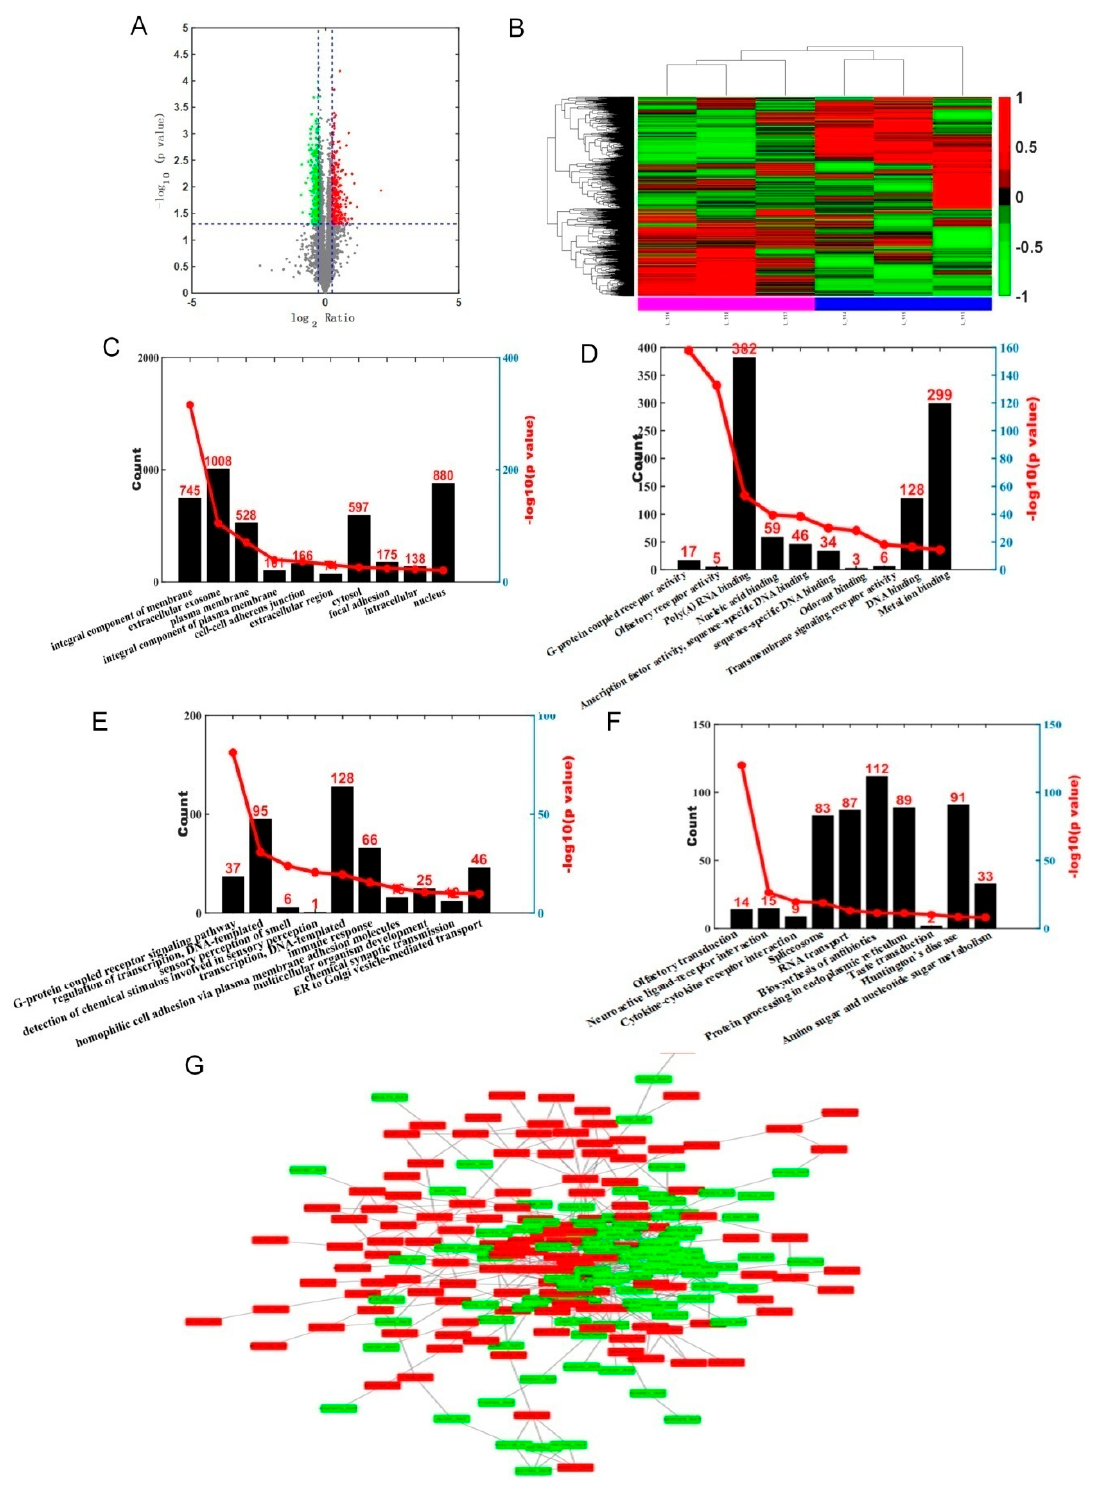
Figure 1. Di ff erentially expressed proteins in silicosis rat lung tissue and bioinformatic analysis. ( A ): Red dots represent upregulated proteins, green dots are downregulated proteins; change was 1.2 fold, p value < 0.05 indicated significant di ff erence. ( B ): Each row represents the expression levels of each protein in di ff erent samples, and the columns represent the expression levels of all proteins in each sample. The colors indicate the expression levels of the proteins. The larger the expression level, the darker the color (red is upregulated, green is downregulated). The tree chart above shows the clustering analysis results of different samples from different experimental groups, and the tree chart on the left shows the clustering analysis results of different proteins from different samples. ( C ):